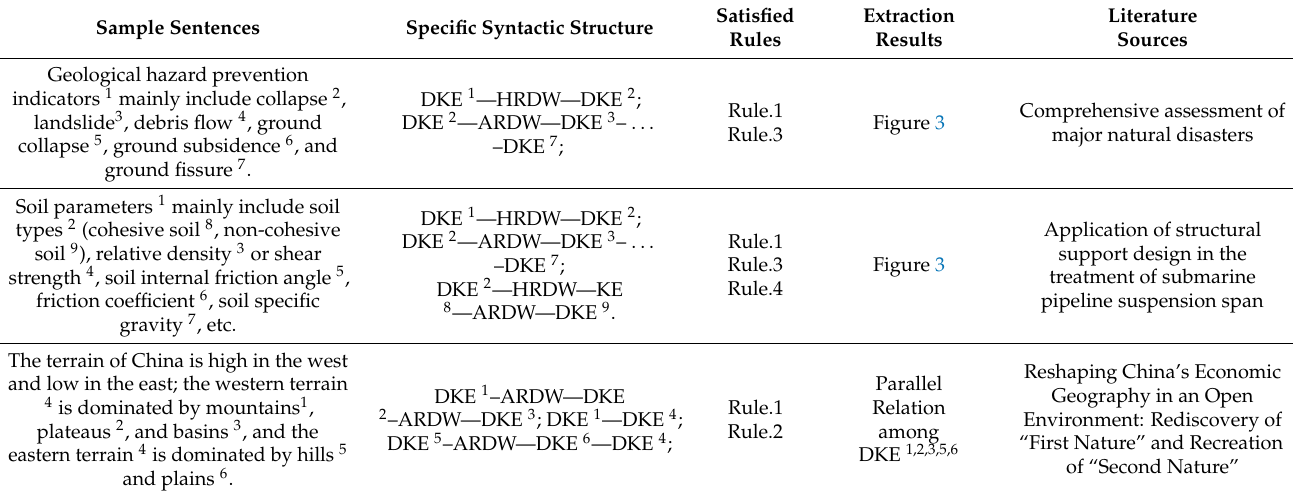
Table 5. Examples of the hierarchical relation extraction